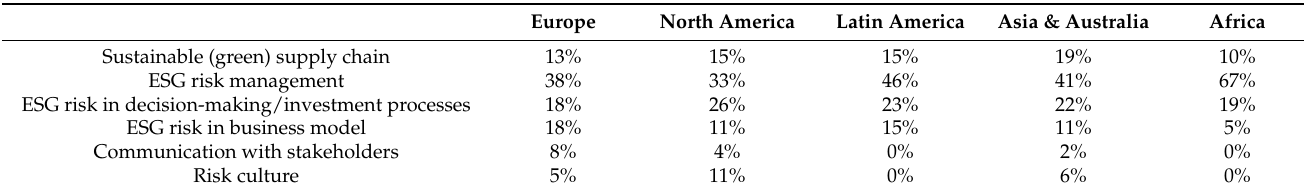
Table 5. ESG risk management practices and enterprise